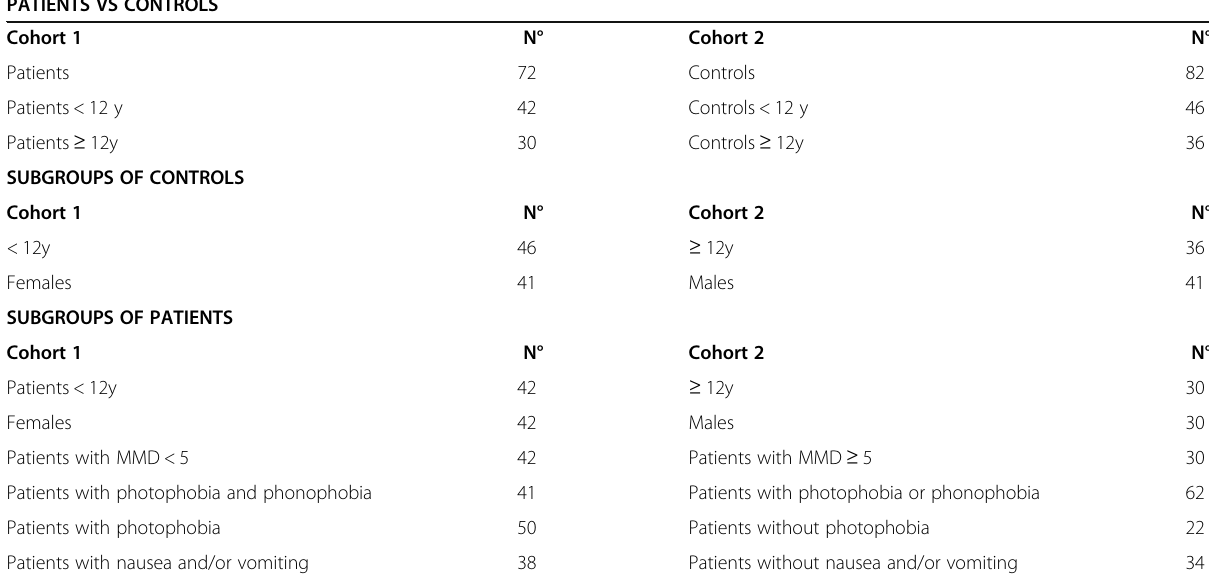
Table 1 Statistical analysis performed on Cortical Thickness and Local Gyrification Index